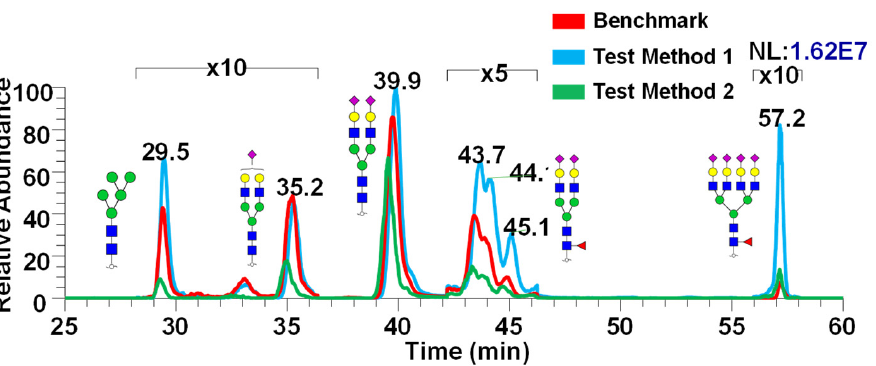
Figure 5. Representative chromatogram depicting the comparison between the three methods. Chromatograms are zoomed in accordingly to better display the peaks. Glycan cartoons are used as described in Figure 1. Glycan structures shown here are putative.